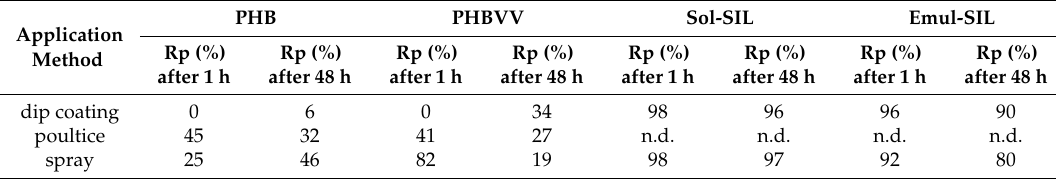
Table 14. Mean ratio of protection of the treatments on limestone after the artificial ageing (n.d.: not